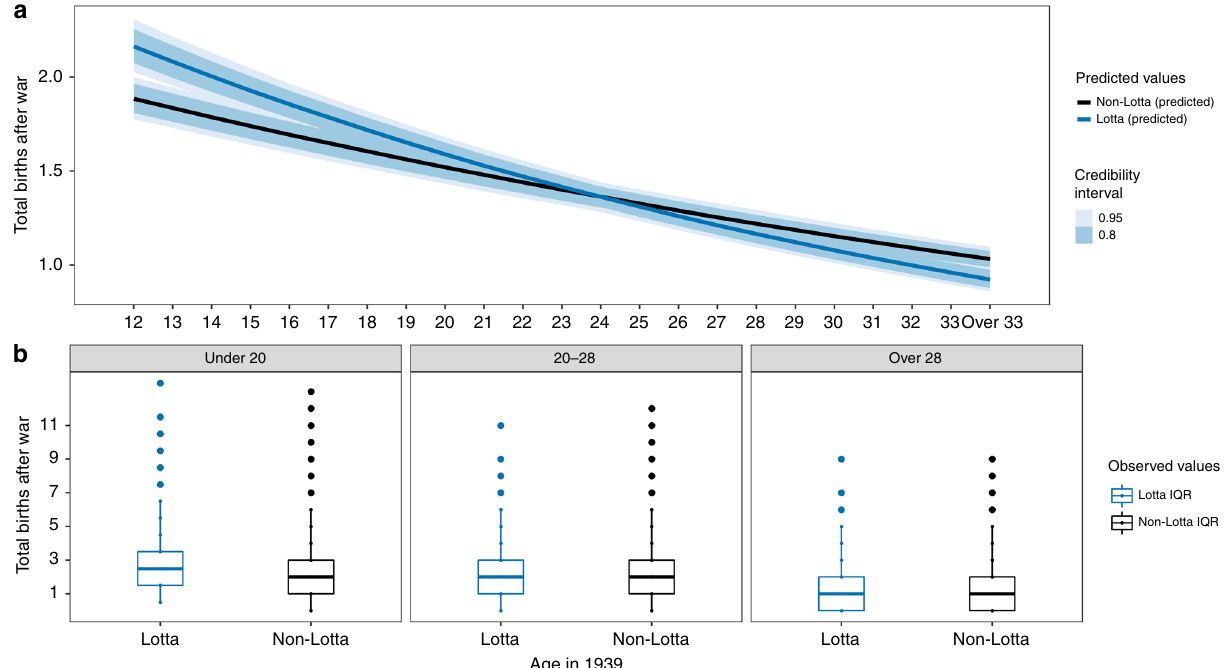
Fig. 2 Younger volunteers of the same age as women who did not volunteer were predicted by the model to have slightly more children after the war ended in 1945. a Model-generated posterior distribution predictions (dark lines), credibility intervals (shaded). b The observed data (median — solid line, box — interquartile range (25% and 75%), whiskers — 5% and 95% intervals) for total reproduction after the war ( y -axis) for age groups “ Under 20 ” , “ 20 – 28 ” , and “ Over 28 ” when the war began in 1939. See Supplementary Materials: Fig S1b and Table S1 (bottom panel, right side) for posterior distributions for all covariates and Fig. S3b for Posterior predictive check for this model. Differences between the model-generated predictions in panel a and the observed data (panel b ) primarily result from the impact of covariates entered into the